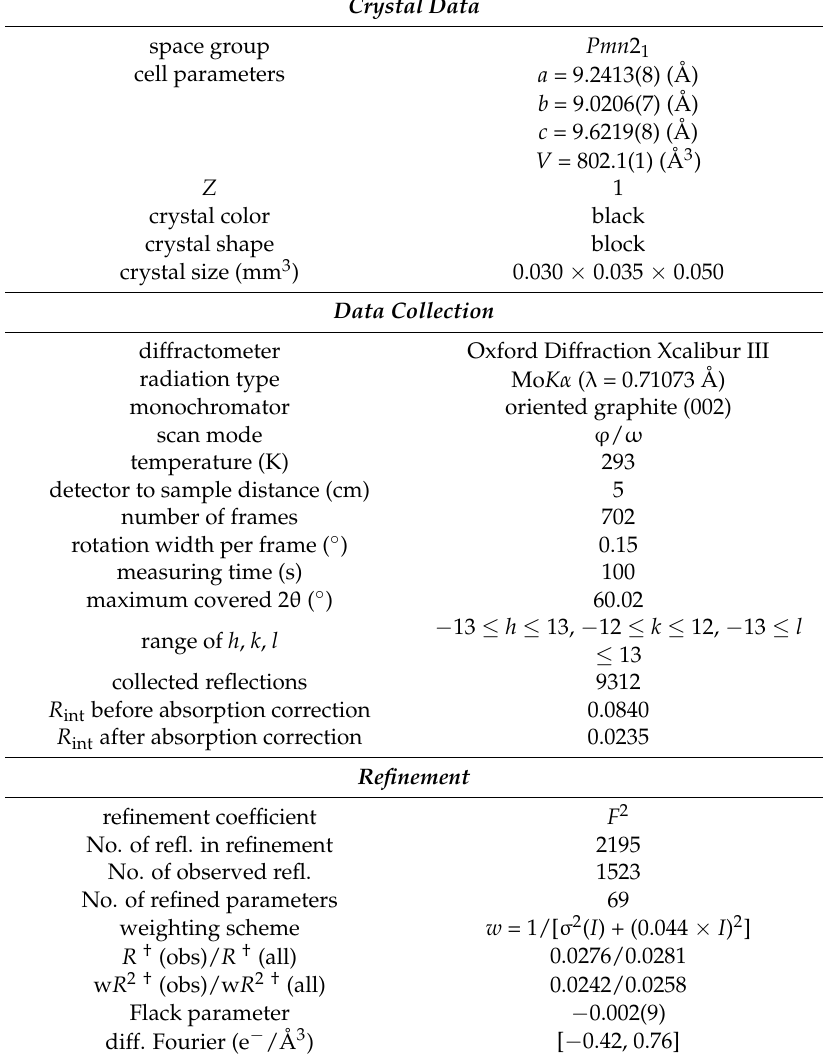
Table 5. Crystal data and details of data collection and refinement for